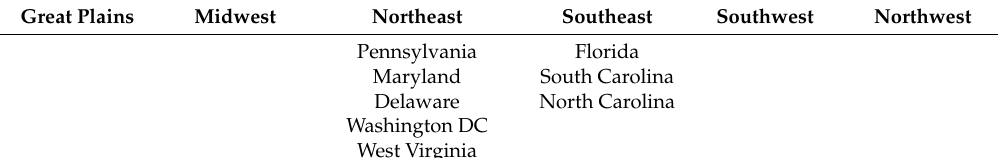
Table 1. NCA regions and the constituent states.